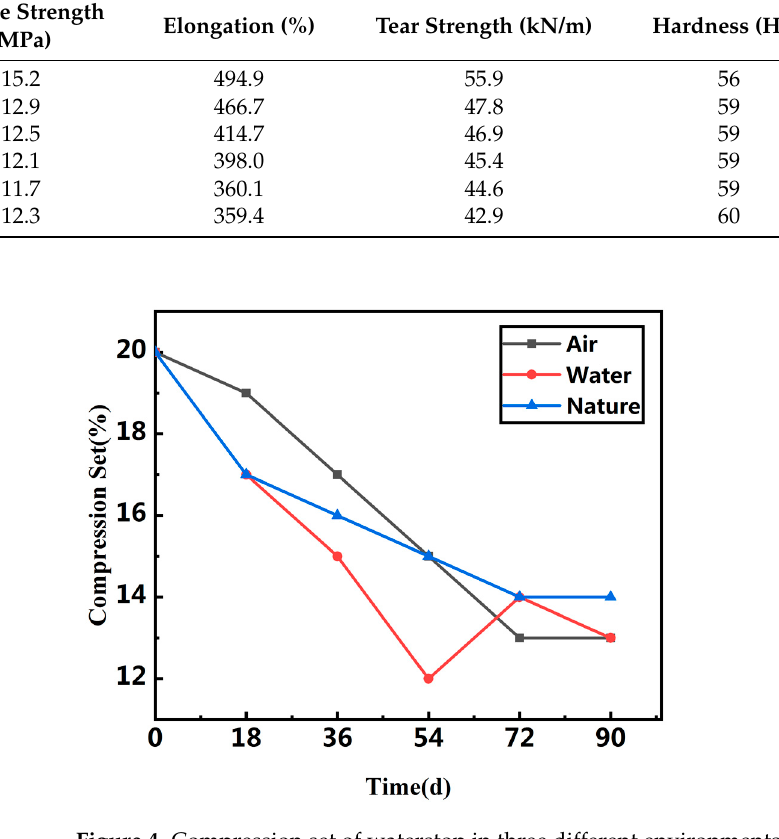
Figure 4. Compression set of waterstop in three different environments.